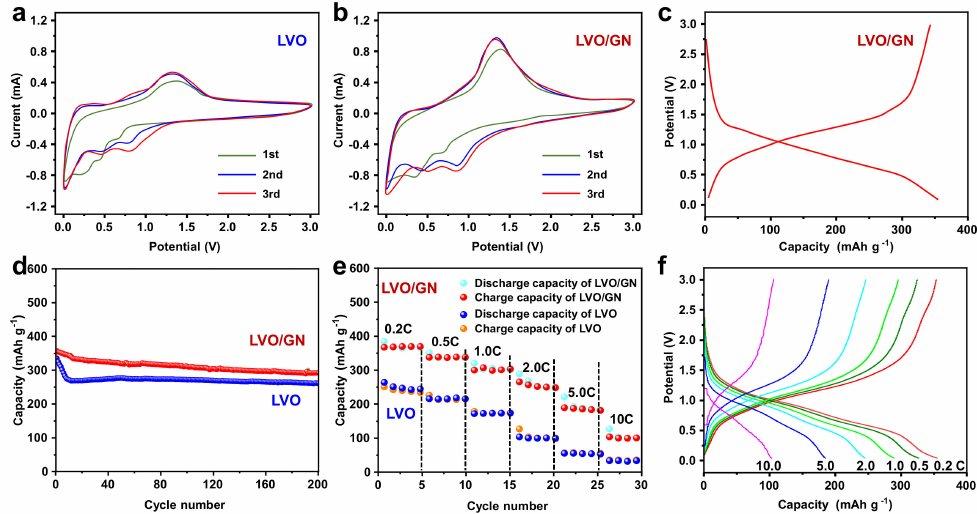
Figure 4. ( a ) CV curves of LVO electrode at a scan rate of 0.2 mV s − 1 . ( b ) CV curves of LVO/GN electrode at a scan rate of 0.2 mV s − 1 . ( c ) The charge/discharge curves of LVO/GN electrode at 0.2 C. ( d ) The cycling performance of LVO electrode and LVO/GN electrode at 0.5 C. ( e ) The rate performance of LVO electrode and LVO/GN electrode. ( f ) The charge/discharge curves of LVO/GN electrode at 0.2 C, 0.5 C, 1.0 C, 2.0 C, 5.0 C, 10.0 C. (1 C = 400 mA g − 1